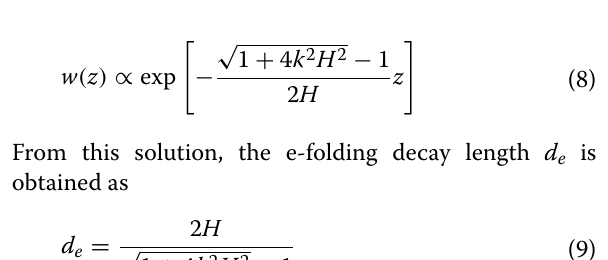
3 K and below were filled with yellow ( d , −